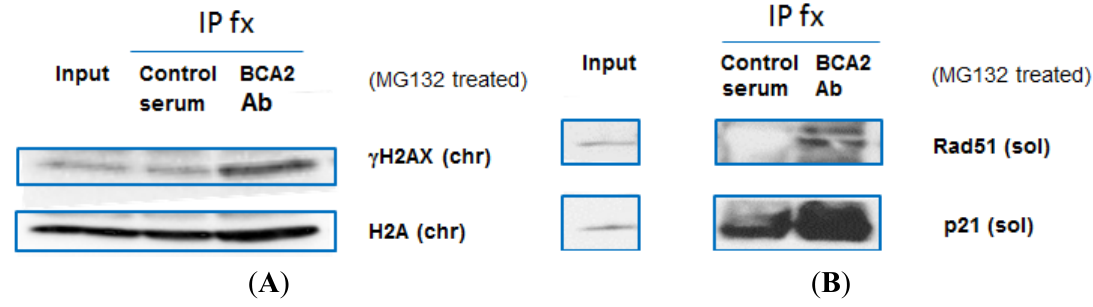
Figure 5. BCA2 interacts with γ H2AX and Rad51. ( A , B ) MCF-7 cells were exposed to 20 μM MG132 for 5 h and collected for immunoprecipitation using goat serum or anti-goat BCA2 antibody along with Protein A/G PLUS Agarose IP Reagent. The precipitated proteins were fractionated and subject to SDS-PAGE and immunoblotting with the indicated antibodies. Description of experimental conditions: chr, the chromatin-bound fraction of cell lysates; sol, the soluble fraction of cell